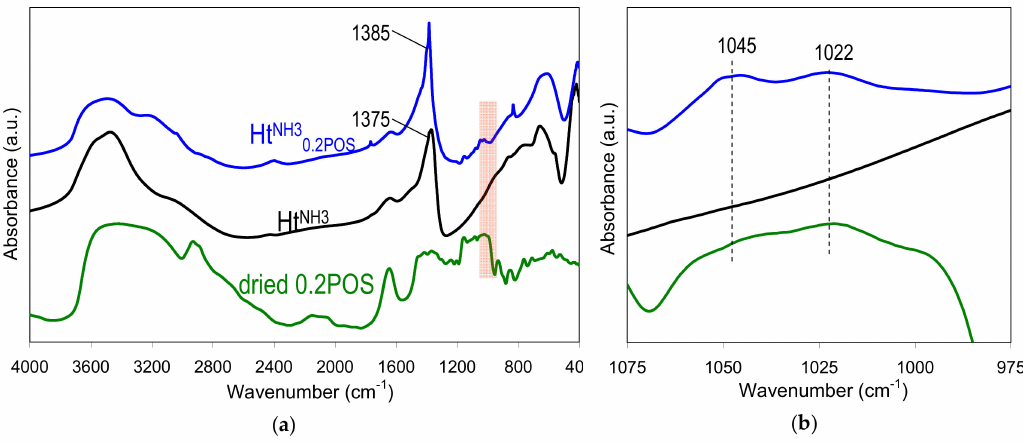
Figure 5. FTIR spectra of: ( a ) sample Ht NH3 0.2POS , Ht NH3 , and dried 0.2 wt.% potato starch gel, with the marked area indicative of starch order-disorder and the ( b ) blown-up fragment of the spectra in the marked